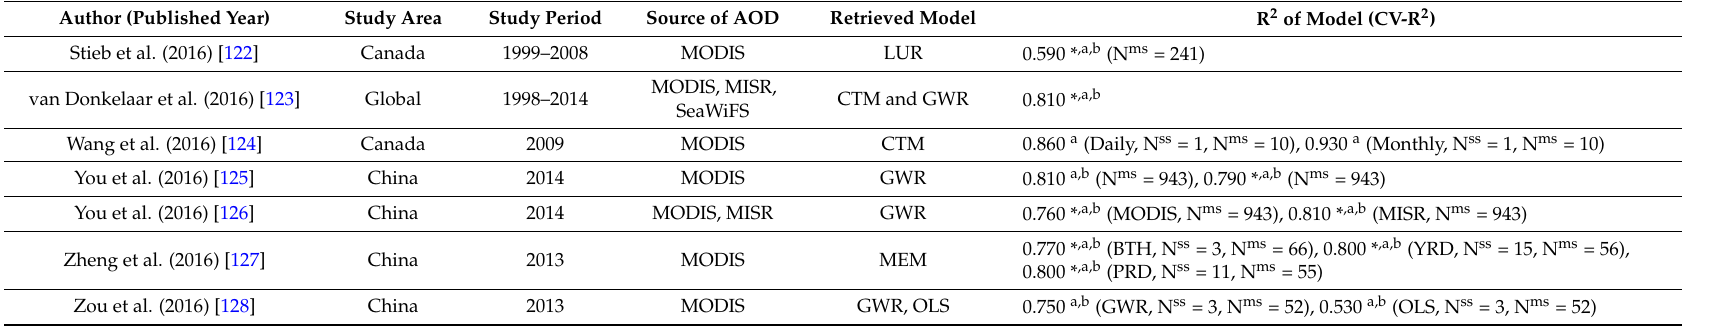
* Sample-based CV-R 2 : Sample-based Cross Validated-coefficient of determination; ** DOY-based CV-R 2 : Day-of Year-based Cross Validated-coefficient of determination; a,b denotes Temporal and Spatial of R 2 , respectively; R 2 denotes daily PM 2.5 expect for note with monthly and yearly; N ms denotes number of PM 2.5 monitoring site; N ss denotes number of study site at city level. The list of abbreviations: (1) Satellite Sensors: MODIS, Moderate Resolution Imaging Spectrometer; MISR, Multi-Angle Imaging Spectrometer; GEOS, Geostationary Operational Environment Satellite; SeaWiFS, Sea-viewing Wide Field-of-view Sensor; POLDER, Polarization of Earth’s Reflectance and Directionality; CALIOP, Cloud-Aerosol Lidar with Orthogonal Polarization; GOCI, Geostationary Ocean Color Imager; OMI, Ozone Monitoring Instrument; (2) Derived models: LC, Linear Correlations; MLR, Multiple Linear Regression; LUR, Land Use Regression; GAM, Generalized Additive Model; MEM, Mixed-Effect Model; CTM, Chemical Transport Model; GLM, General Linear regression Model; ANN, Artificial Neural Networks; TSM, Two-Stage Model; SVR, Support Vector Regression; GTWR, Geographically and Temporally Weighted Regression; TWR, Temporally Weighted Regression; TVM, Two-Variate Method; MVM, Multivariate Method; OLS, Ordinary Least Squares model; SEC, Surface Extinction Coefficient; Nested MEM, Nested Mixed Effects Model; Non-nested MEM, Non-nested Mixed Effects Model; DSA, Deletion/substitution/addition; BMEM, Bayesian Maximum Entropy method; MCA, Maximum Covariance Analysis; CMCA, Combined Maximum Covariance Analysis (3) R 2 of model, Coefficient of determination of model: NARR, North American Regional Reanalysis;